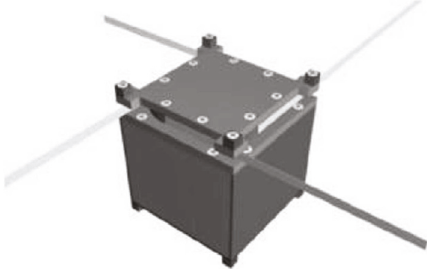
Figure 8: The deployable antenna used in PolySat